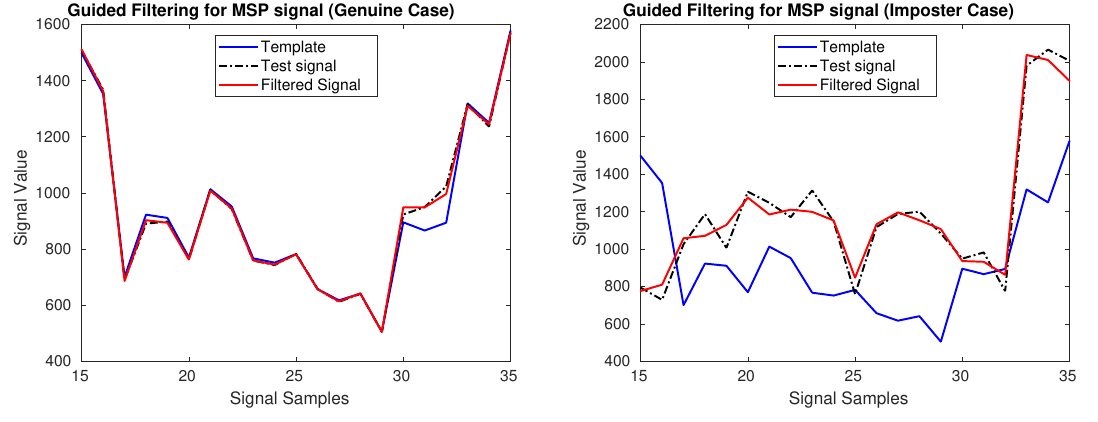
Figure 9. An effect of the application of a user template guided filter for MSP signal. The blue line shows the user template which is enrolled in the device. The black line represents the test signal, and the red line is guided filtering result with using template as a guide